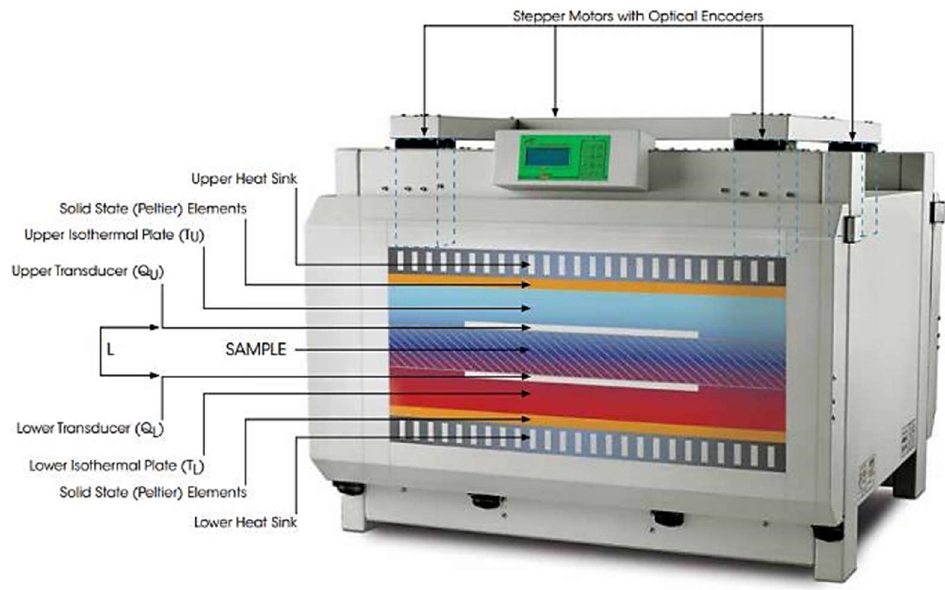
Figure 2. Heat flow meter measurement scheme [26].